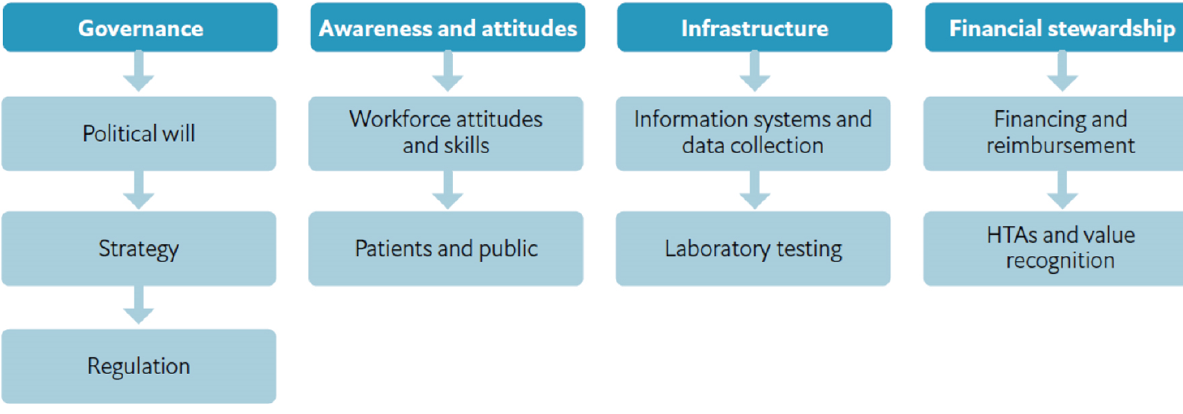
Figure 5. Personalized medicine assessment framework created by “The Economist Intelligence Unit”.